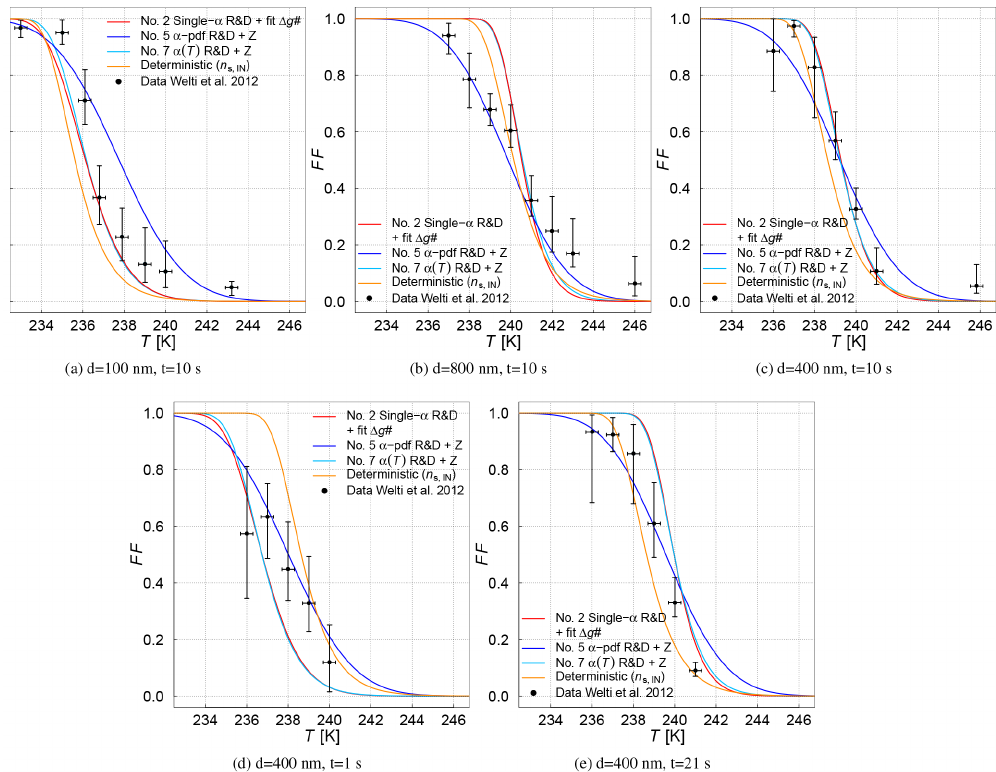
Figure 5. Calculated FF of kaolinite for three different times and three sizes using the single- α R&D + fit (cid:49)g # formulation (CNT2), the α -pdf R&D + Z formulation (CNT5), and the α(T ) R&D + Z formulation (CNT7) with corresponding fit parameters (see Table 2) and a simplified immersion freezing parameterization scheme based on Niemand et al. (2012) compared to the dataset. Panels (a–c) show the particle size dependence ( t = 10s) and panels (c–e) show the time dependence ( d =